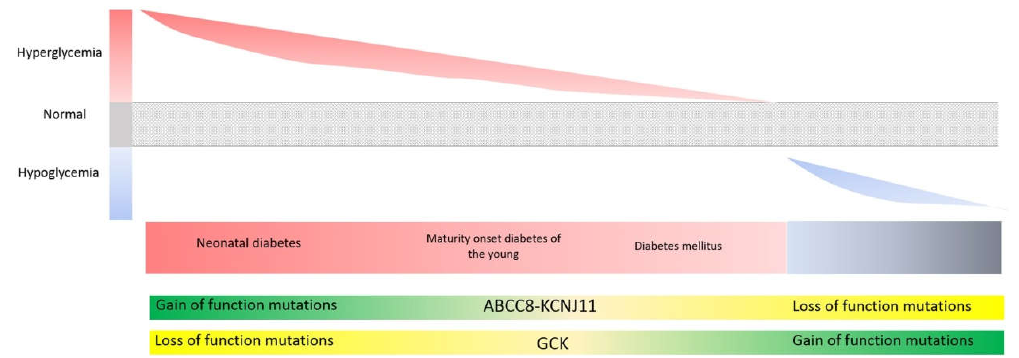
Figure 8. Phenotypic spectrum associated with mutations in genes involved in insulin secretion; ABCC8 , KCNJ11 , and GCK . ABCC8 , KCNJ11 , and GCK